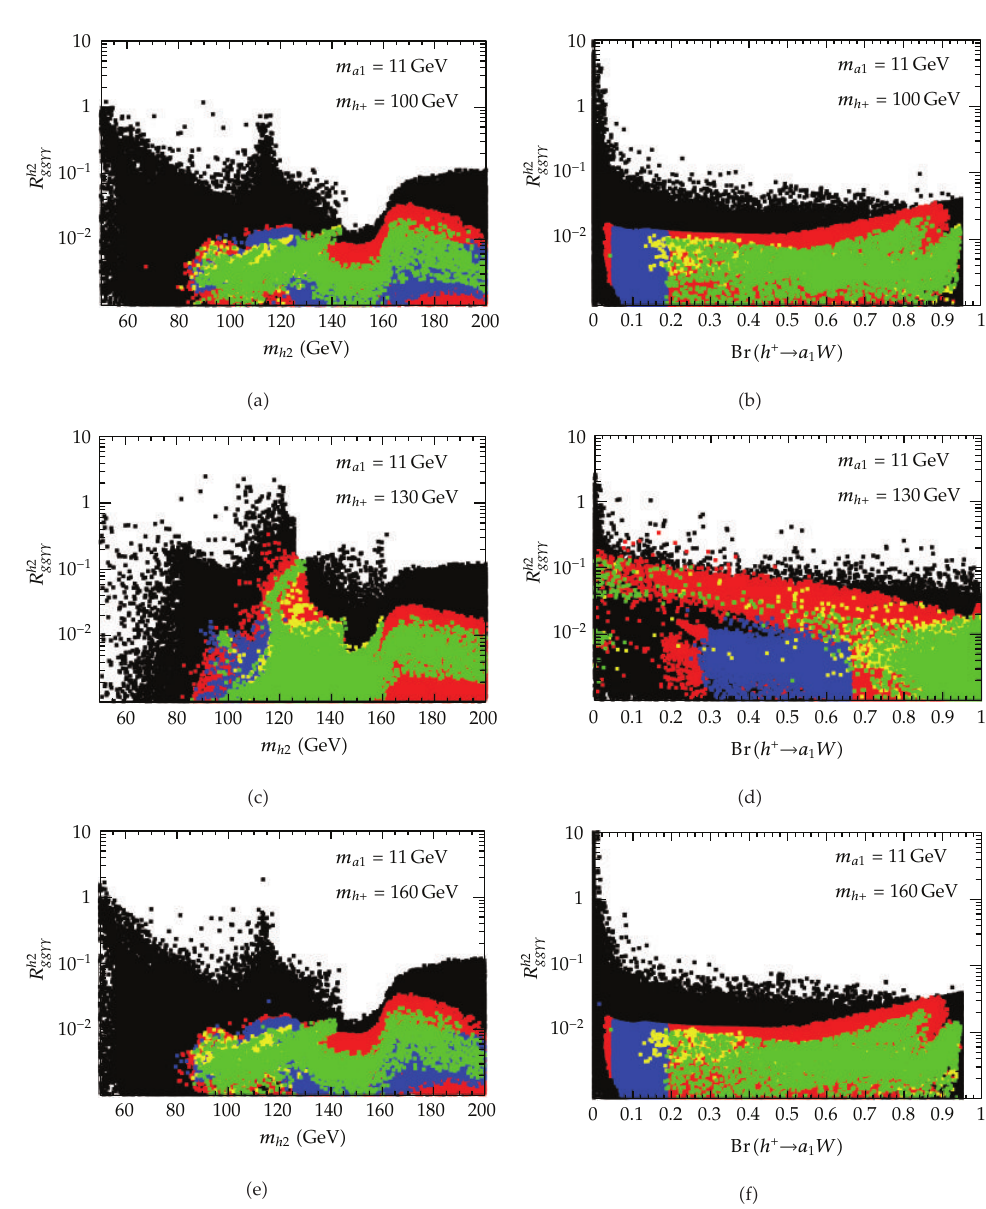
Figure 11: The signal for h 2 → γγ relative to the standard model (cid:2) left (cid:3) and the branching fraction for h ± → (cid:7) 11GeV and m (cid:2) top (cid:3) , 130 (cid:2) middle (cid:3) , and 160 (cid:2) bottom (cid:3) GeV, a 1 W (cid:2) right (cid:3) in a scan with m a h ± fixed at 100 1 respectively. The colour coding for the various constraints is the same as in Figure